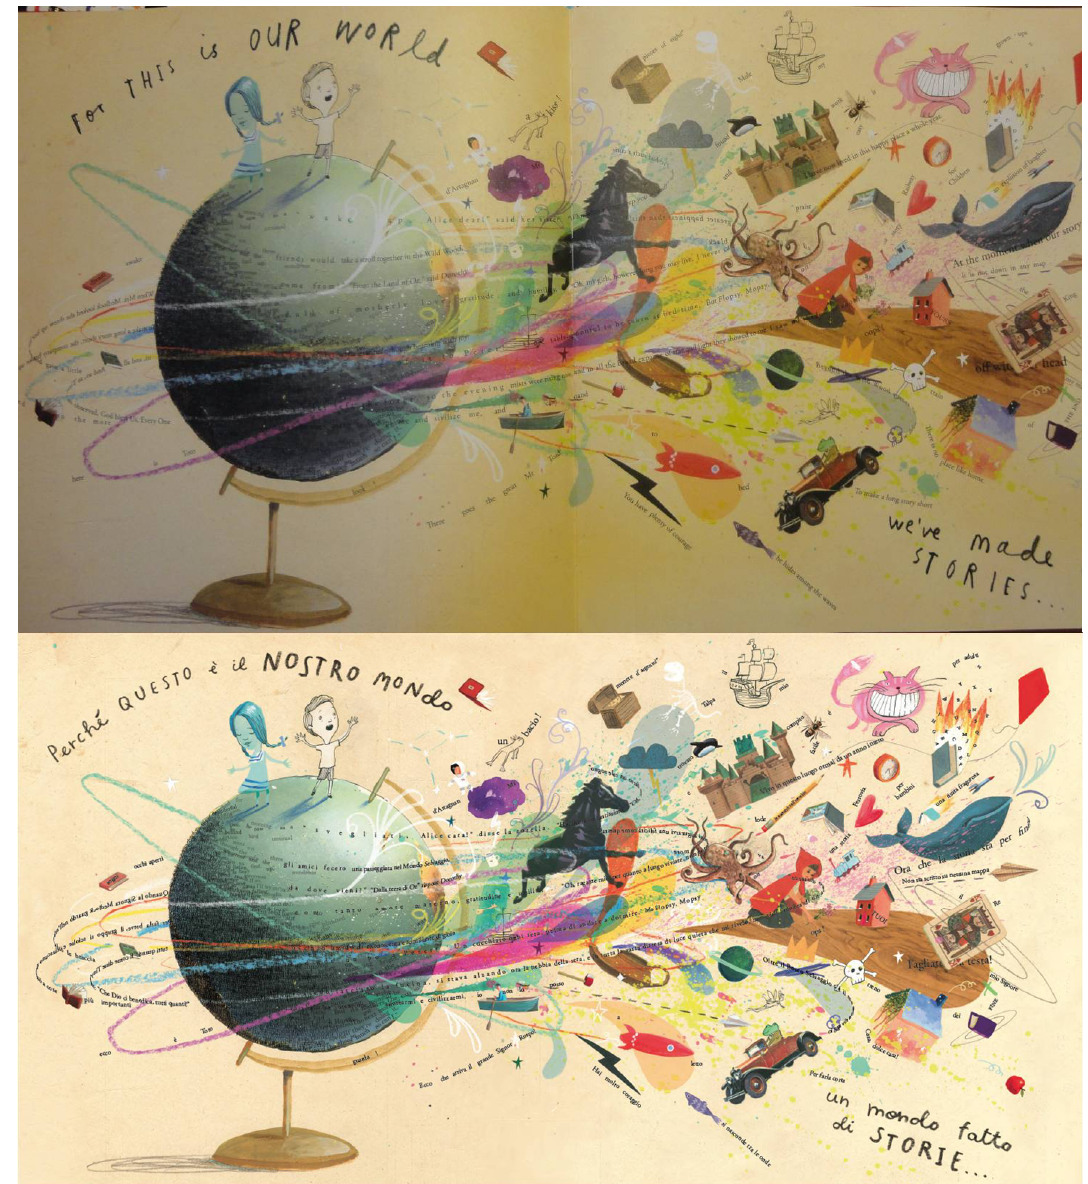
Figure A19. Jeffers O.; Winston S. A child of books, Walker Books, London, 2016; Jeffers O.; Winston S. La bambina dei libri, Lapis, Roma,